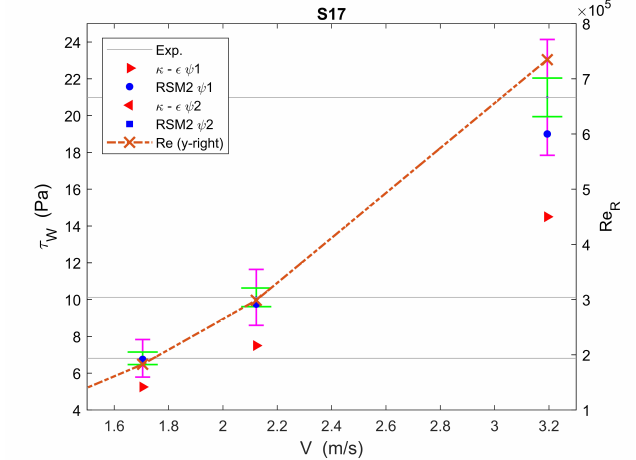
Figure 10. τ y = 0.16 Pa, m = 0.0328 Pas n , n = 0.6043 and D = 100 mm.